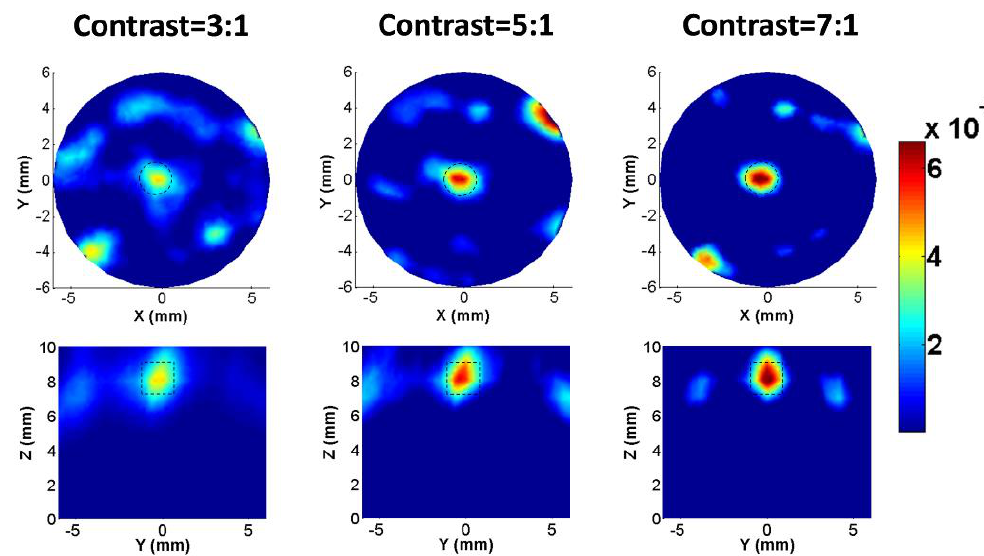
Figure 3. FMT images for a target having different ICG contrast (3:1, 5:1 and 7:1) relative to the background at a depth of 2